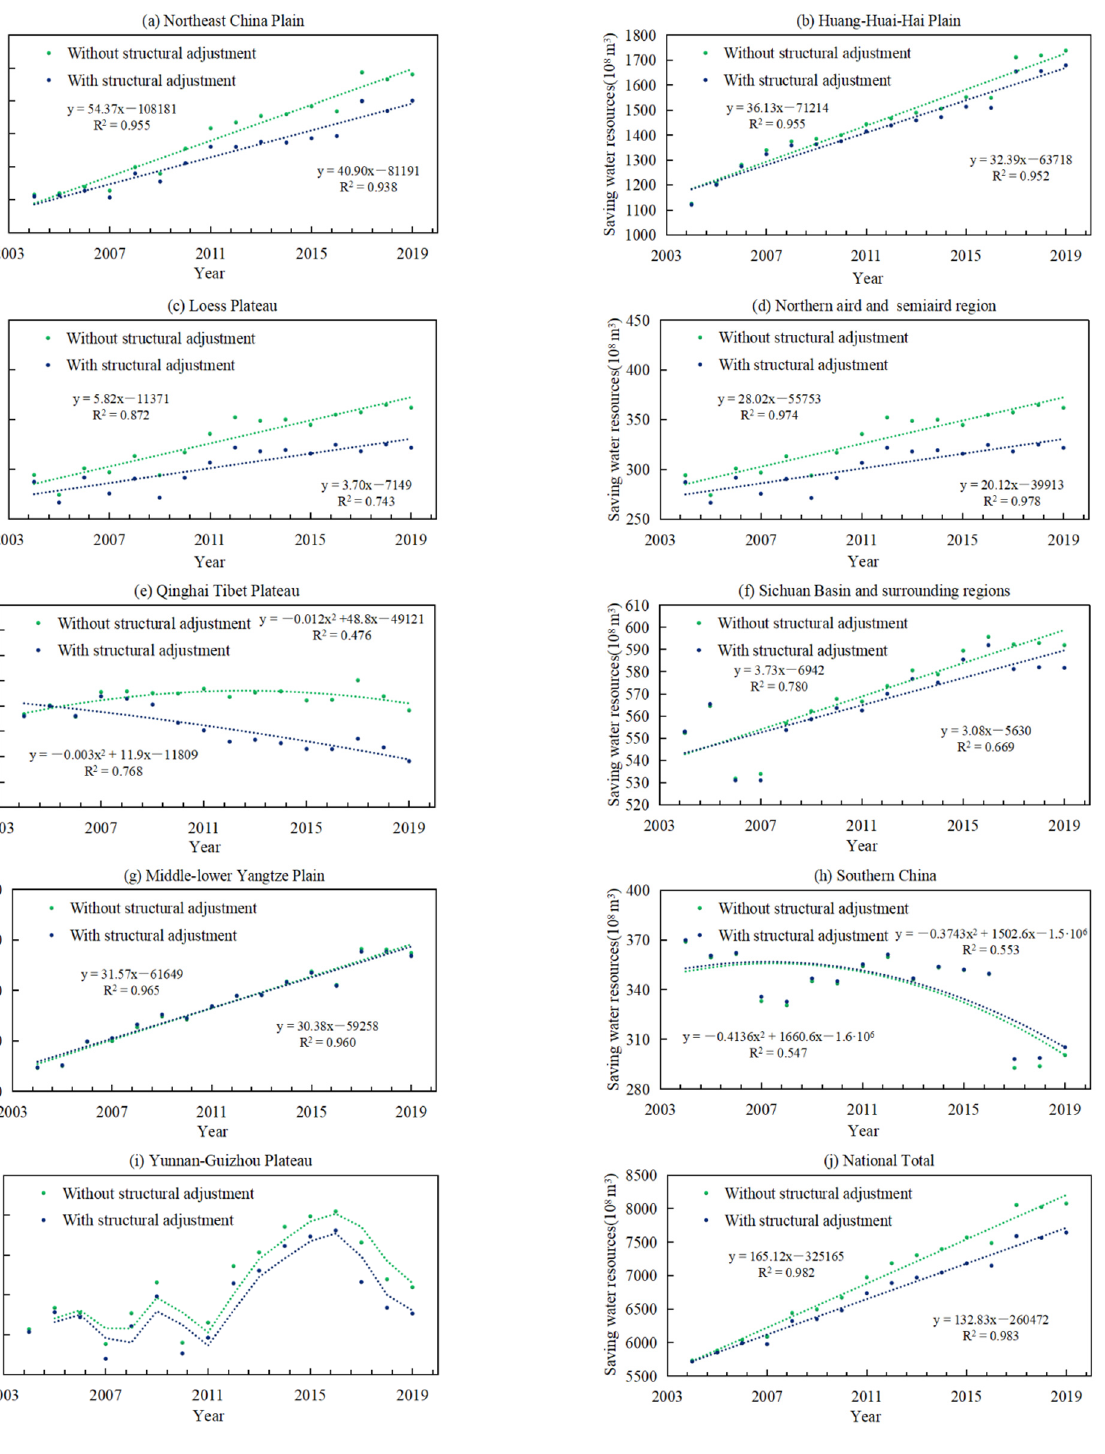
Figure 6. The evolution trend of water resource consumption with or without the adjustment of grain planting structure. ( a–d , f , g , j ) fit the linear approximation, ( e , h ) are described by polynomials, ( i ) uses the moving average method to express the evolution trend. y represents the water resources consumption with or without the adjustment of grain planting structure, x represents the year, R 2 expresses the explanatory degree of the relationship between the x and y variables. The values of R 2 range from 0 to 1. The higher the value, the closer relationship between the x and y variables. Green and blue line are fitted curve, which means the evolution trend of water resources consumption without structural adjustment or with the structural adjustment,